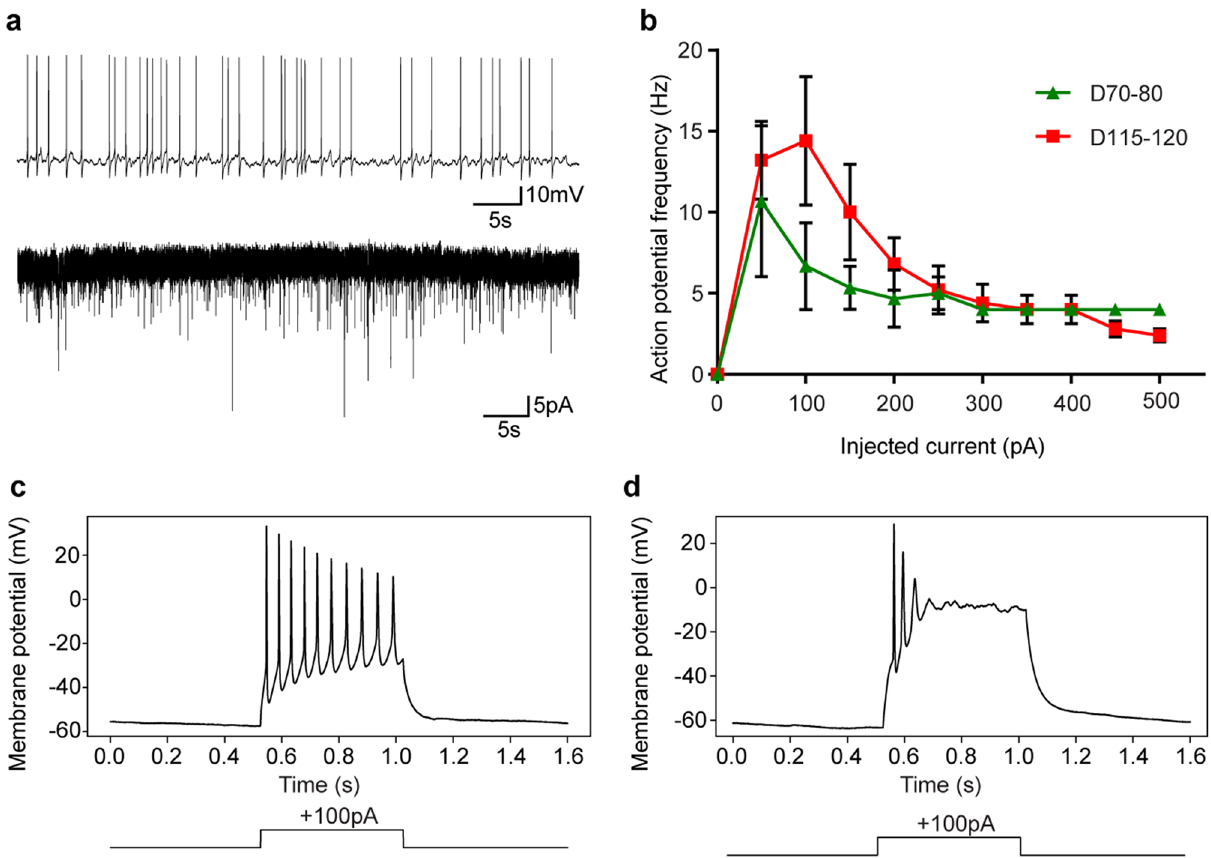
Figure 2. Electrophysiological properties of neurons in cerebral spheroids . ( a ) Upper trace: representative trace in current clamp mode showing spontaneous action potentials. Lower trace: representative trace in voltage- clamp mode showing spontaneous putative sEPSCs. ( b ) Input–output curves as a measure of excitability in spheroids at different times of culture. Neurons in spheroids show a maximum action potential frequency around 50–100 pA of injected current after which a depolarization block is observed. Data represents mean ± SEM of excitable cells described in Table 1. No statistical difference observed between day 70–80 and